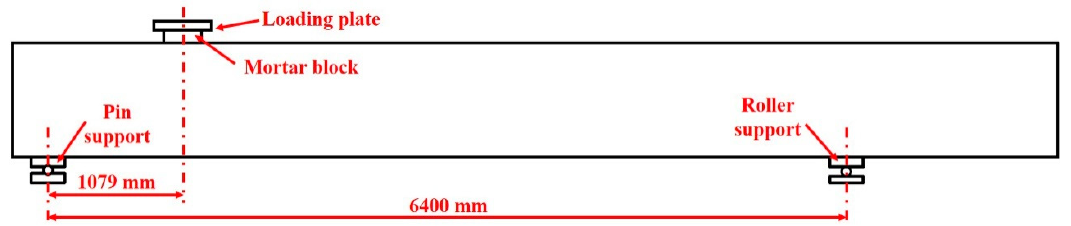
Figure 3. Three-point bending testing.